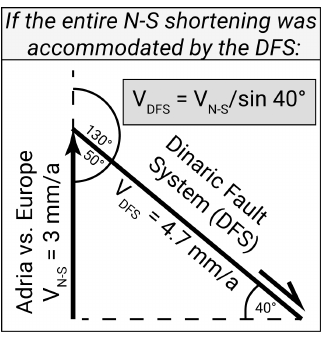
Figure 12. Simple maximum slip rate estimation for the DFS in western Slovenia. A northward velocity of Adria with respect to Europe of 3mm/a (Weber et al., 2010) would lead to 4.7mm/a of right-lateral strike slip on the Dinaric Fault System if this were the only structure to accommodating the deformation. Hence, the com- bined slip rates of the DFS cannot exceed 4.7mm/a. Atanackov et al. (2021) estimate a combined right-lateral slip rate of ∼ 2.5mm/a for the western part of the DFS. The remaining slip must be accom- modated further to the east, where another set of shorter right-lateral faults is present (Atanackov et al., 2021), and by the Sava and the Periadriatic faults (Fig.